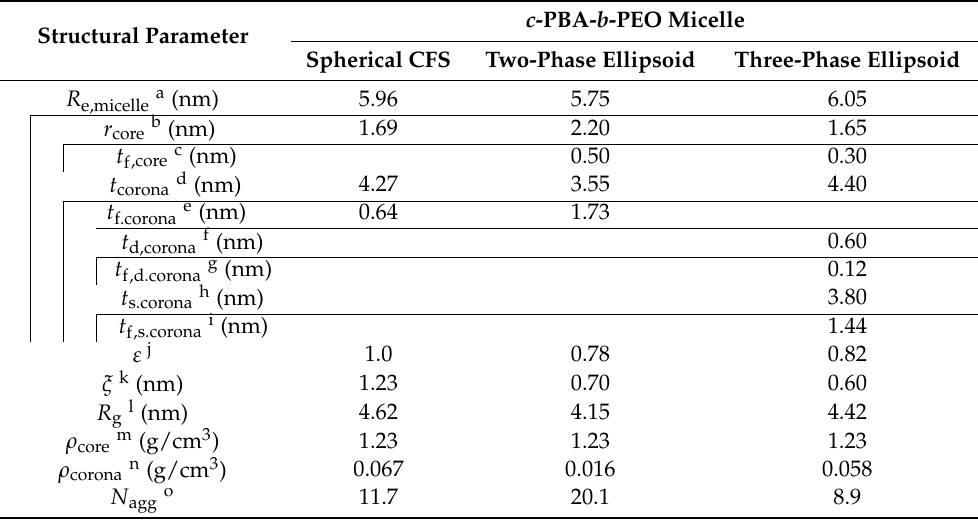
Table 4. Structural parameters of the c -PBA- b -PEO micelle obtained from the quantitative analysis of scattering data with various model approaches.